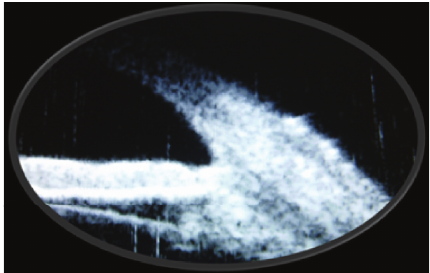
Figure 3: Slit lamp picture showing partial resolution of the mass at 2 weeks.